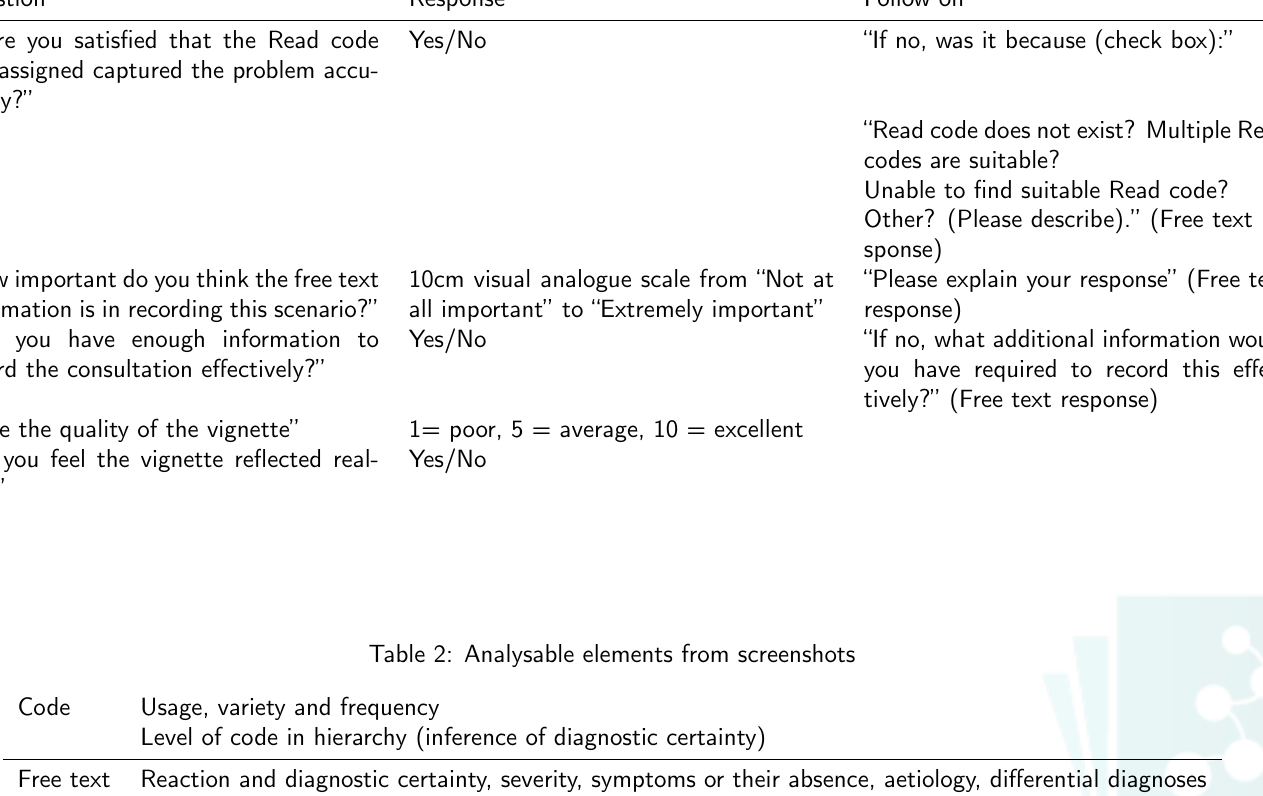
Table 1: Questions used to assess the quality of vignettes and their answer modalities